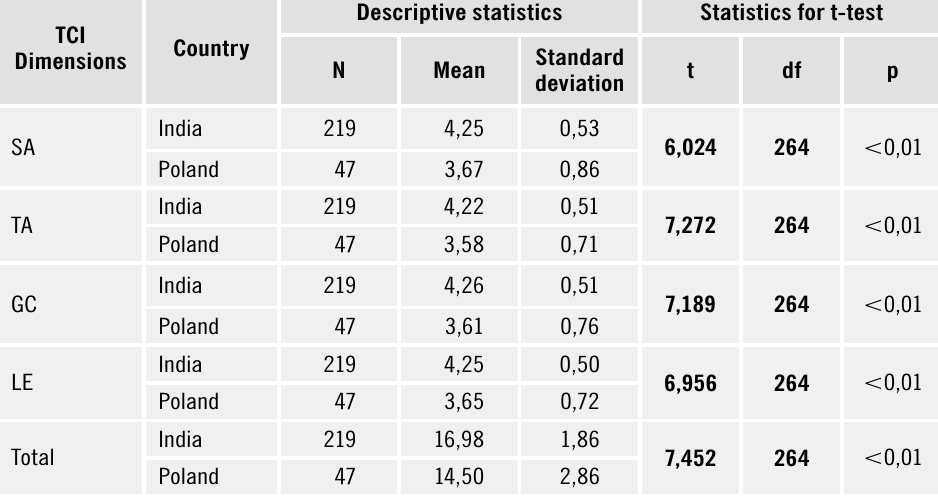
Table 5. Descriptive statistics and the t-test between respondents of different nationalities Descriptive statistics Statistics for t-test TCI Country Standard Dimensions N Mean deviation